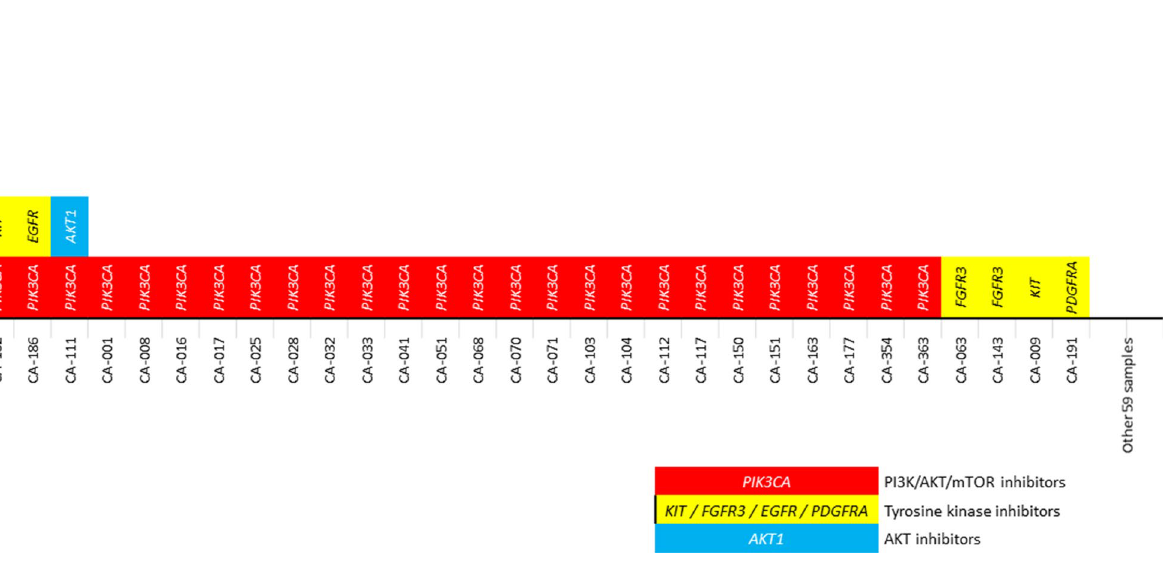
Figure 3. An overview of actionable genetic mutations in cervical cancers. CA-xx represents identification numbers for pathologic specimens of each